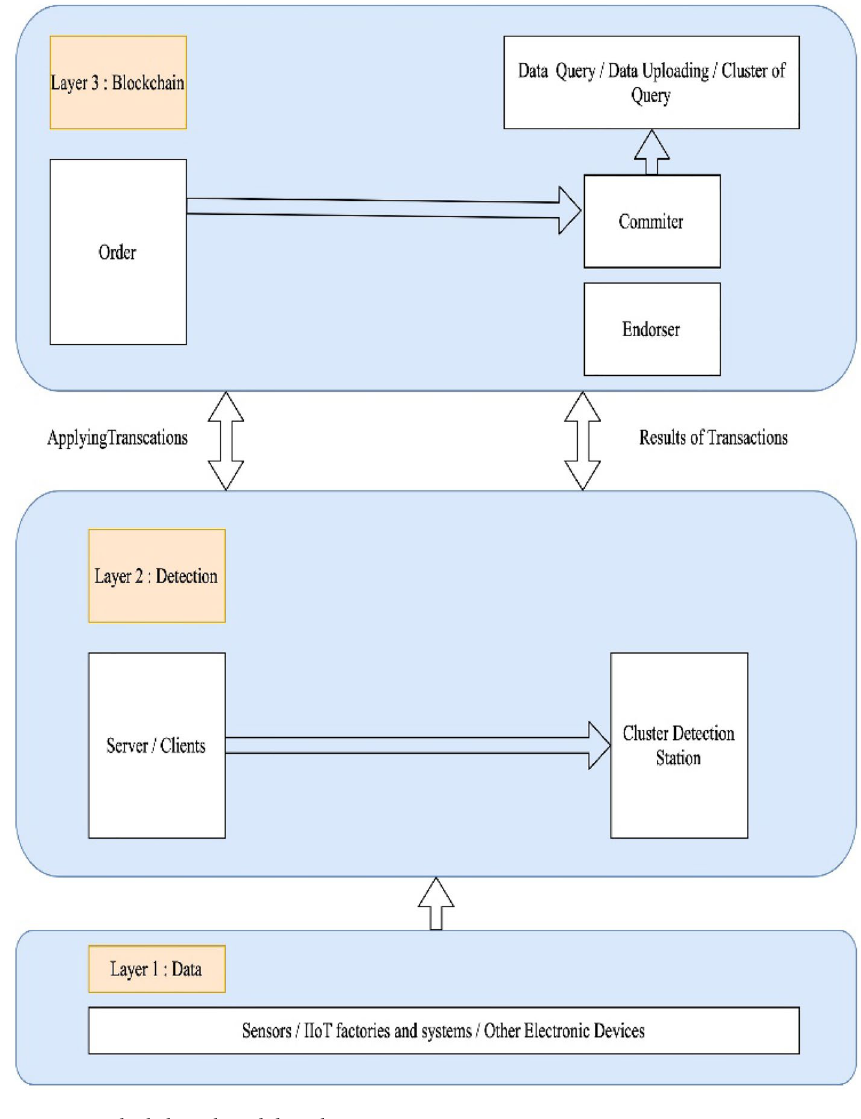
Figure 4. Blockchain-based data sharing